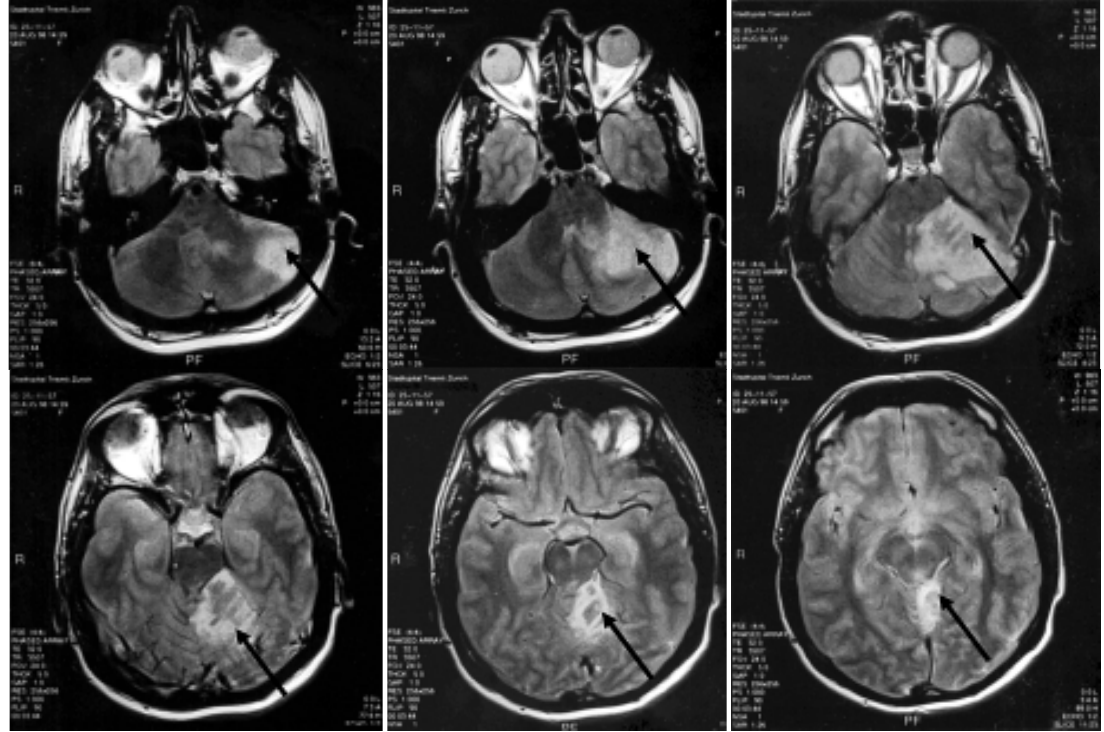
Fig. 3 – Demonstration by magnetic nuclear resonance of a ischemic infarction of the left cerebral hemisphere (arrows) after the injection of contrast in patient Nº 44 of this